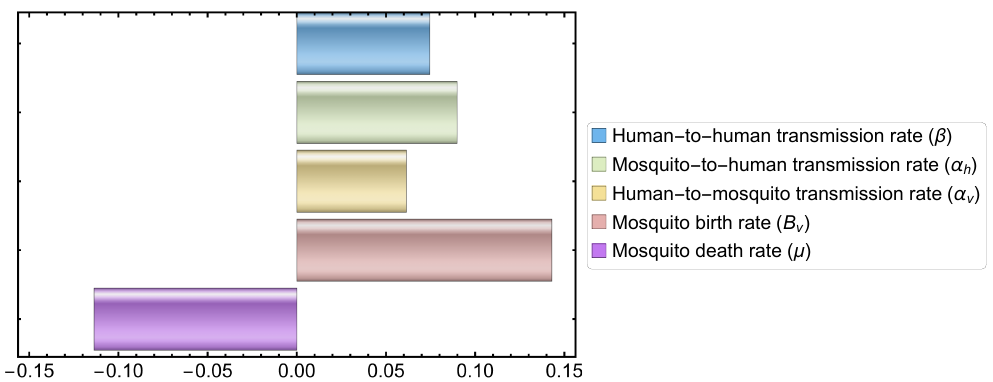
Figure 7. Partial rank correlation coefficients of the five parameters which can be subject to control measures. Parameters with positive (or negative) PRCC are positively (or negatively) correlated with the total number of cases.